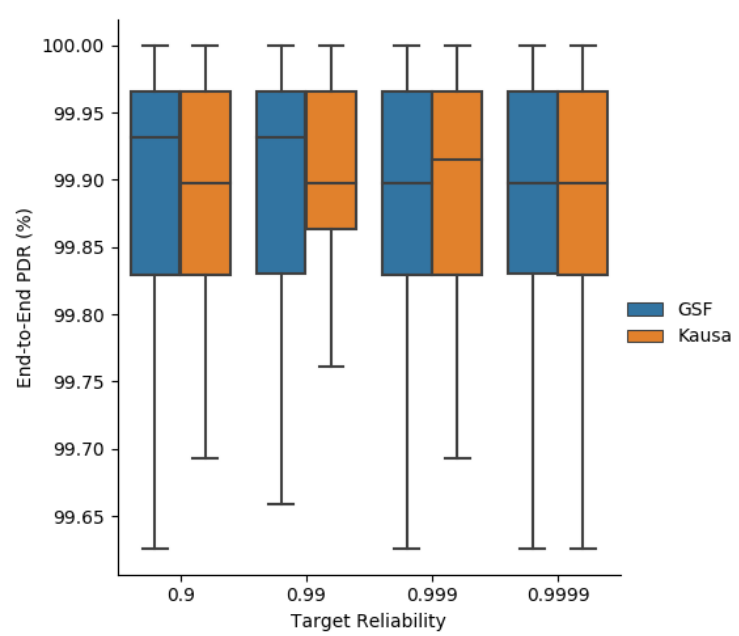
Figure 18. End-to-end delivery rate obtained with MOpt and Kausa .